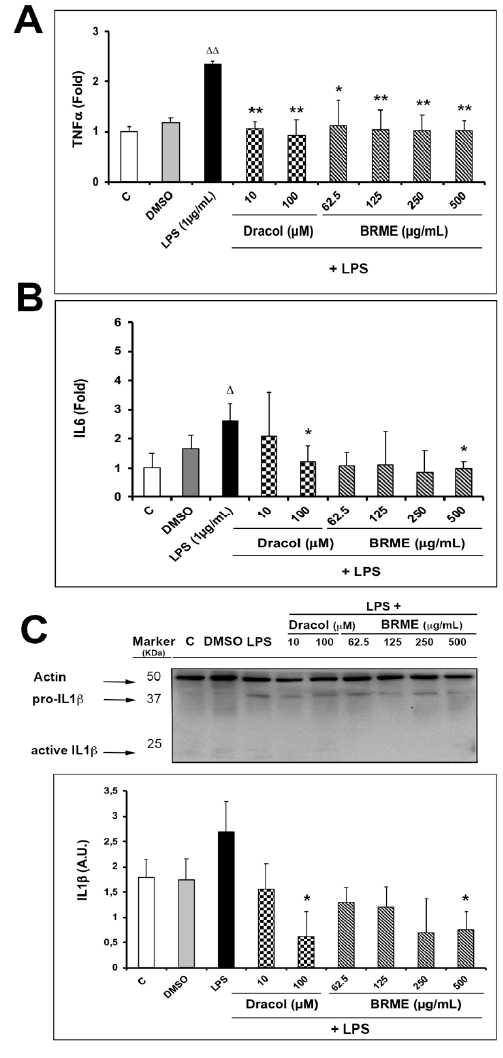
Figure 5. Pro-inflammatory cytokine levels after treatment with BRME and Dracol in the presence of 1 µ g / mL LPS. TNF α and IL6 ( A , B ) levels are expressed as percentage in comparison with control. ( C ) Western Blotting and data analysis of the protein level of IL1 β. Values compared to positive control (LPS 1 µg/mL) and control cells are expressed as mean ± SD from five independent experiments. * p ≤ 0.05, ** p ≤ 0.01 by Student’s t -test vs LPS sample. ΔΔ p ≤ 0.01 vs C (control cells).